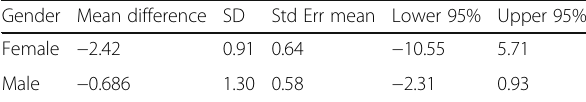
Table 2 The difference in sinus width by